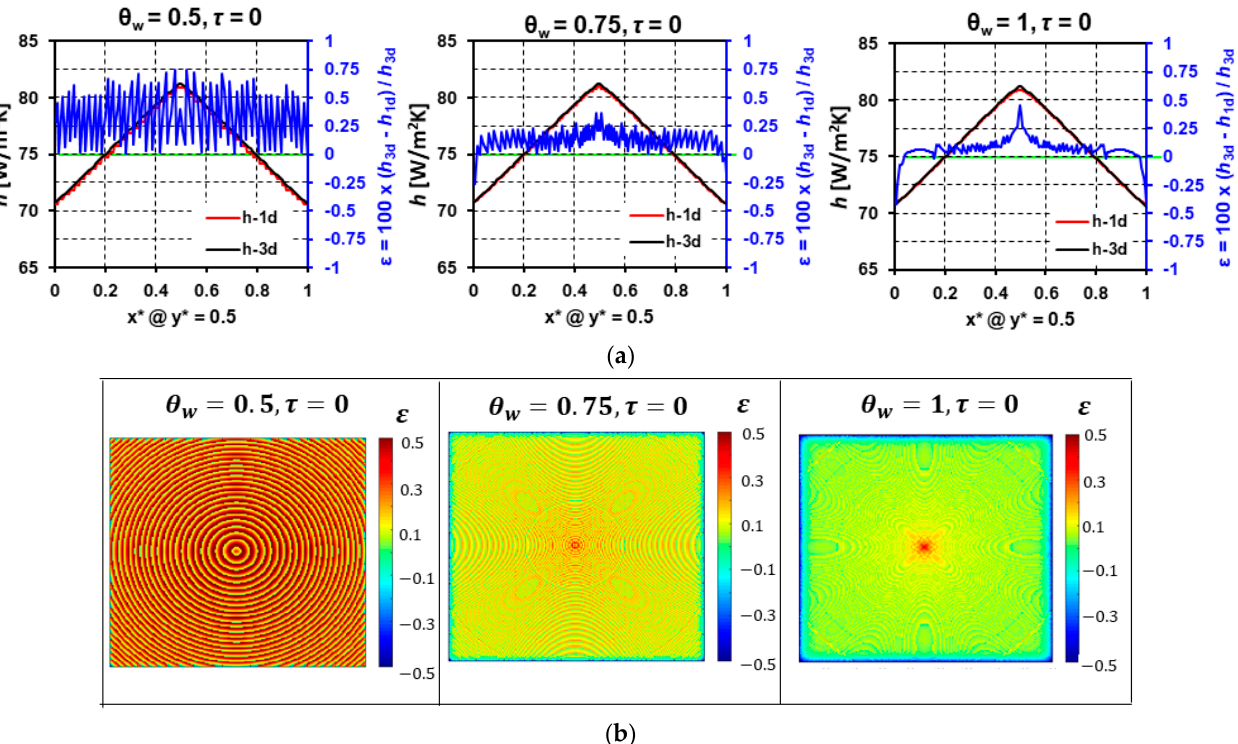
Figure 9. Method B, Case I: ( a ) Local h variation at the surface centerline and their relative % differences, ( b ) 𝜀 map for three different wall temperature tracking.